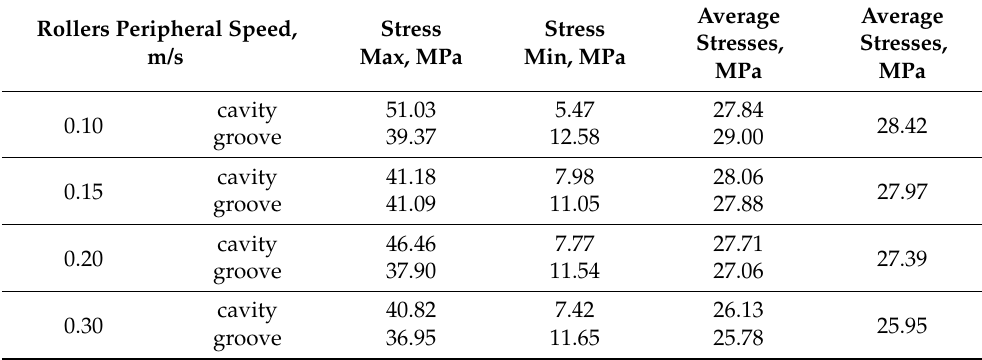
Table 2. Characteristics of stresses on the surfaces of the forming elements during briquetting of calcium